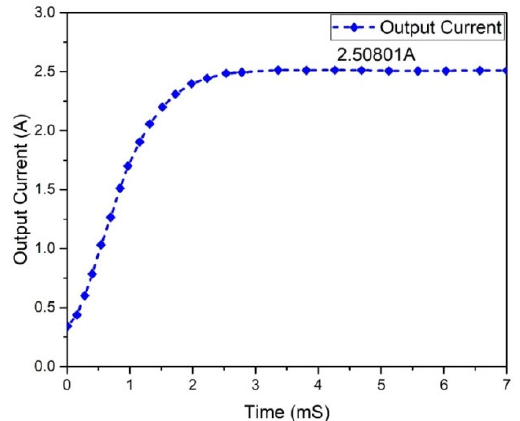
Figure 13. Output current of presented boost converter.